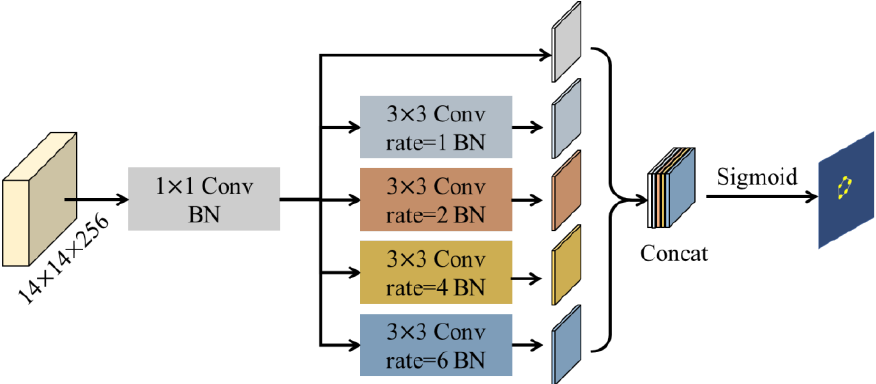
Figure 4. The architecture diagram of the BPP module.